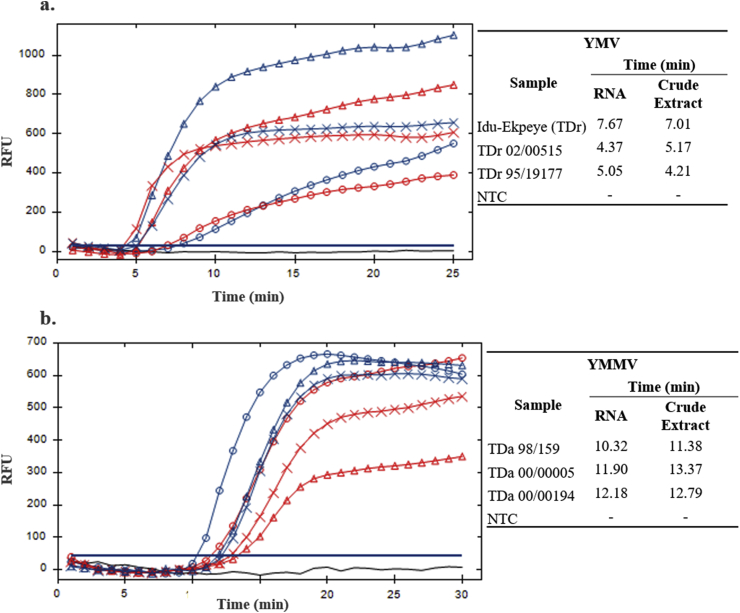
RT-RPA, with purified RNAs as template and Direct RT-RPA, with crude plant extracts as template for detection of YMV (a.) and YMMV (b.). Blue lines are obtained from purified RNAs and red lines obtained from crude plant extracts. Circle corresponds to Idu-Ekpeye (TDr) and TDa 98/159 samples; Triangle corresponds to TDr 02/00515 and TDa 00/00005 samples; Cross corresponds to TDr 95/19177 and TDa 00/00194 samples. NTC refers to the non-template control. Fluorescence intensities were plotted against time in minutes. The solid bar corresponds to the threshold line (graph generated by CFX ManagerTM software). Tables on the right side of the amplification plots show the threshold times (min) of each reaction. (For interpretation of the references to colour in this figure legend, the reader is referred to the Web version of this article.)